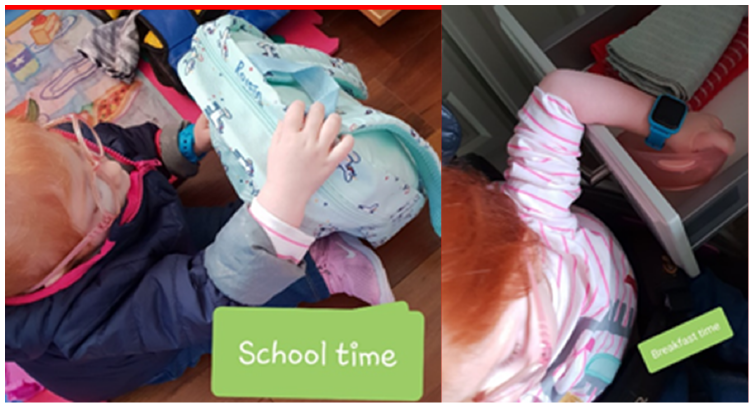
Figure 3. Rachel getting ready for school in the morning. Int. J. Environ. Res. Public Health 2020 , 17 , x